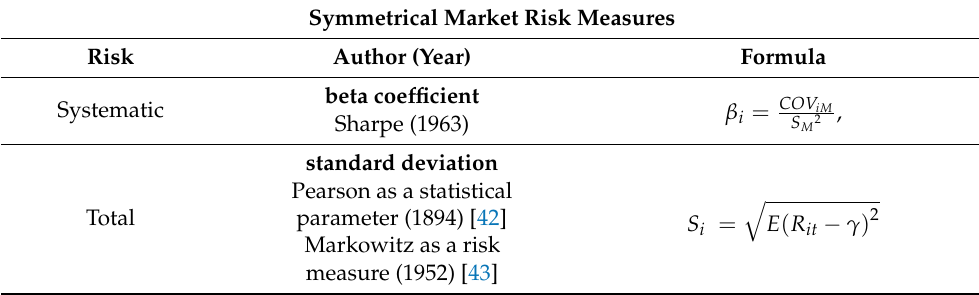
Table 1. Selected market risk measures in symmetrical (variance) and asymmetrical